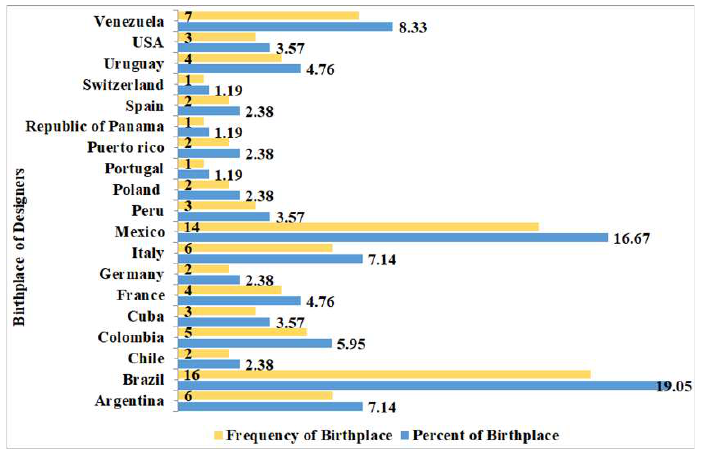
Figure 1. Birthplaces of designers.